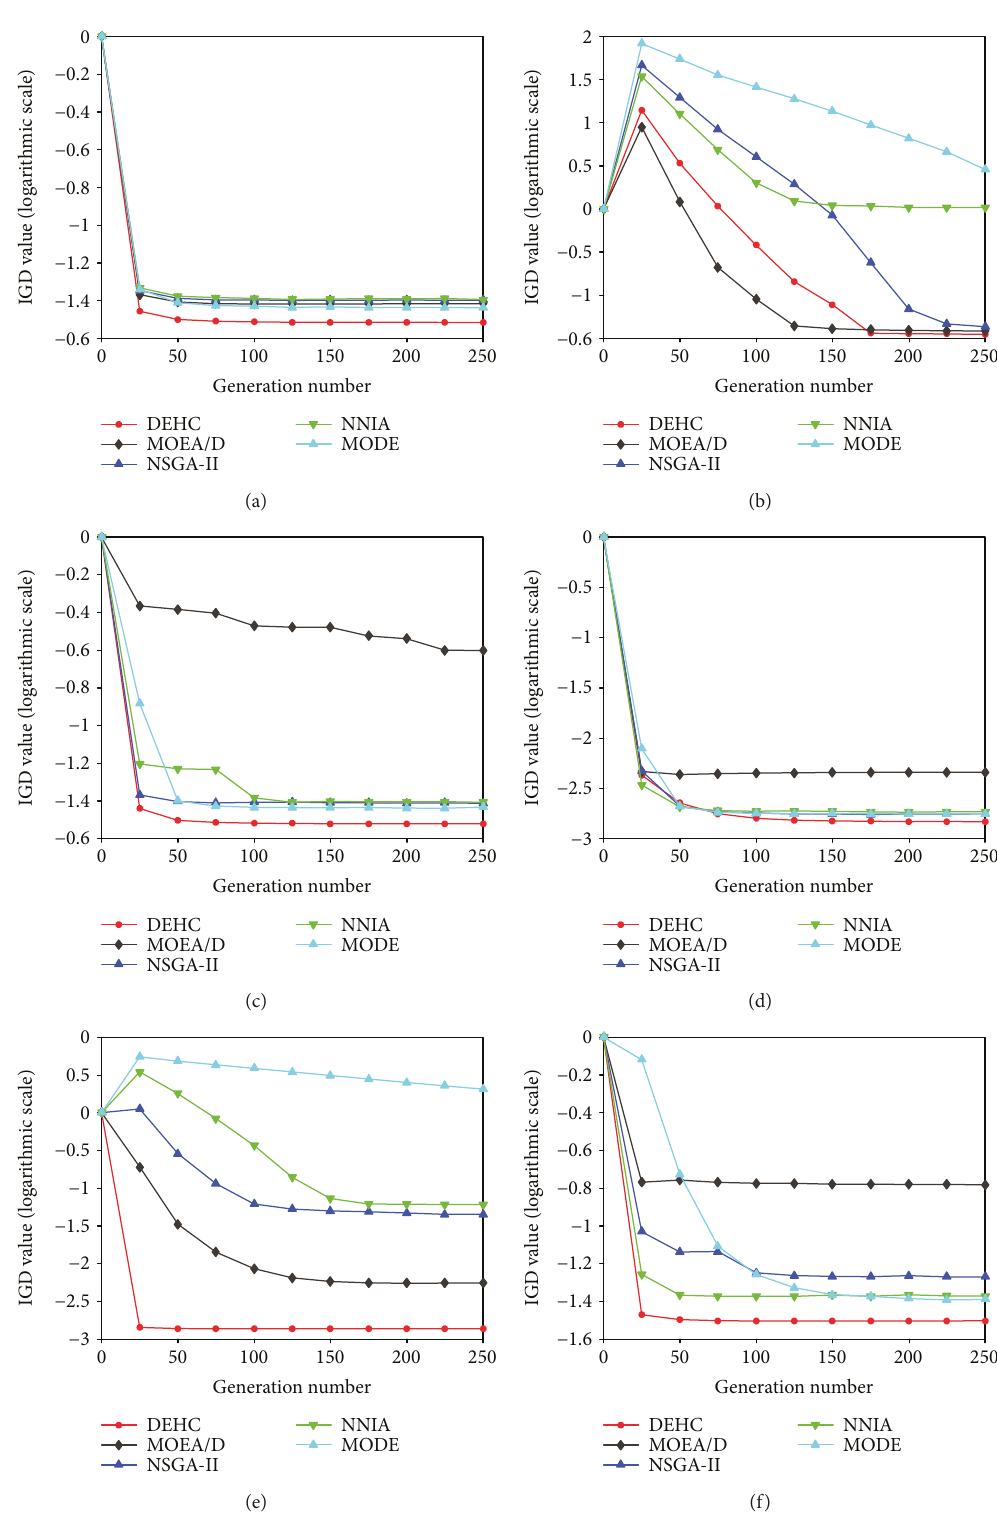
Figure 5: Median IGD values versus the evolution time. (a) DTLZ2, (b) DTLZ3, (c) DTLZ4, (d) DTLZ5, (e) DTLZ6, and (f)